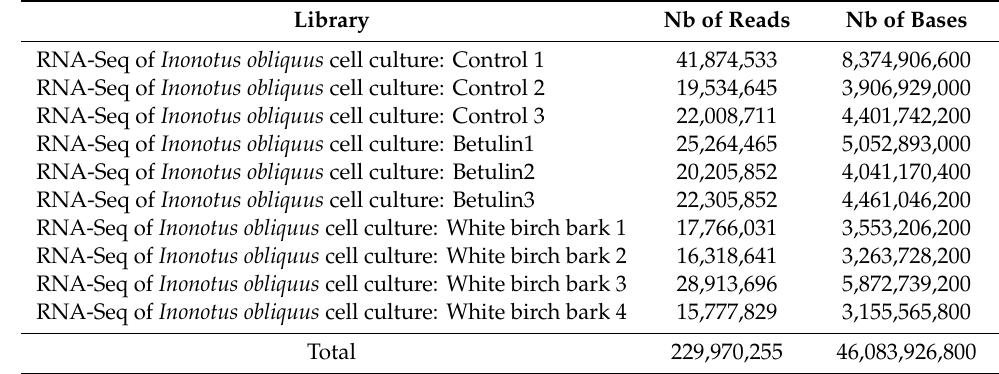
Table 3. List of Inonotus obliquus RNA-Seq library sequenced using Illumina HiSeq4000 deposited to the NCBI Sequence Read Archive under the accession